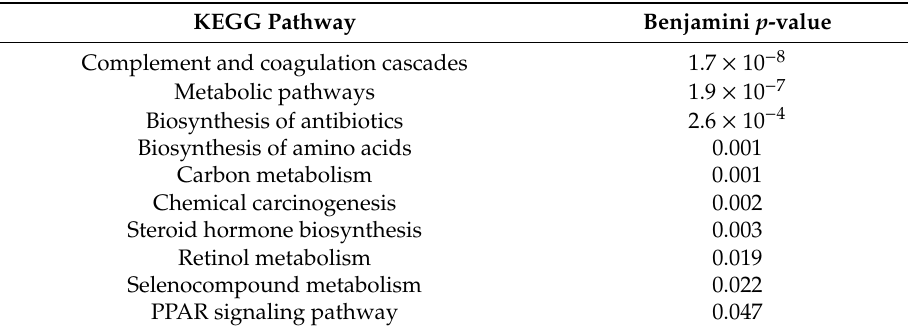
Table 5. KEGG pathways enriched in overlapping